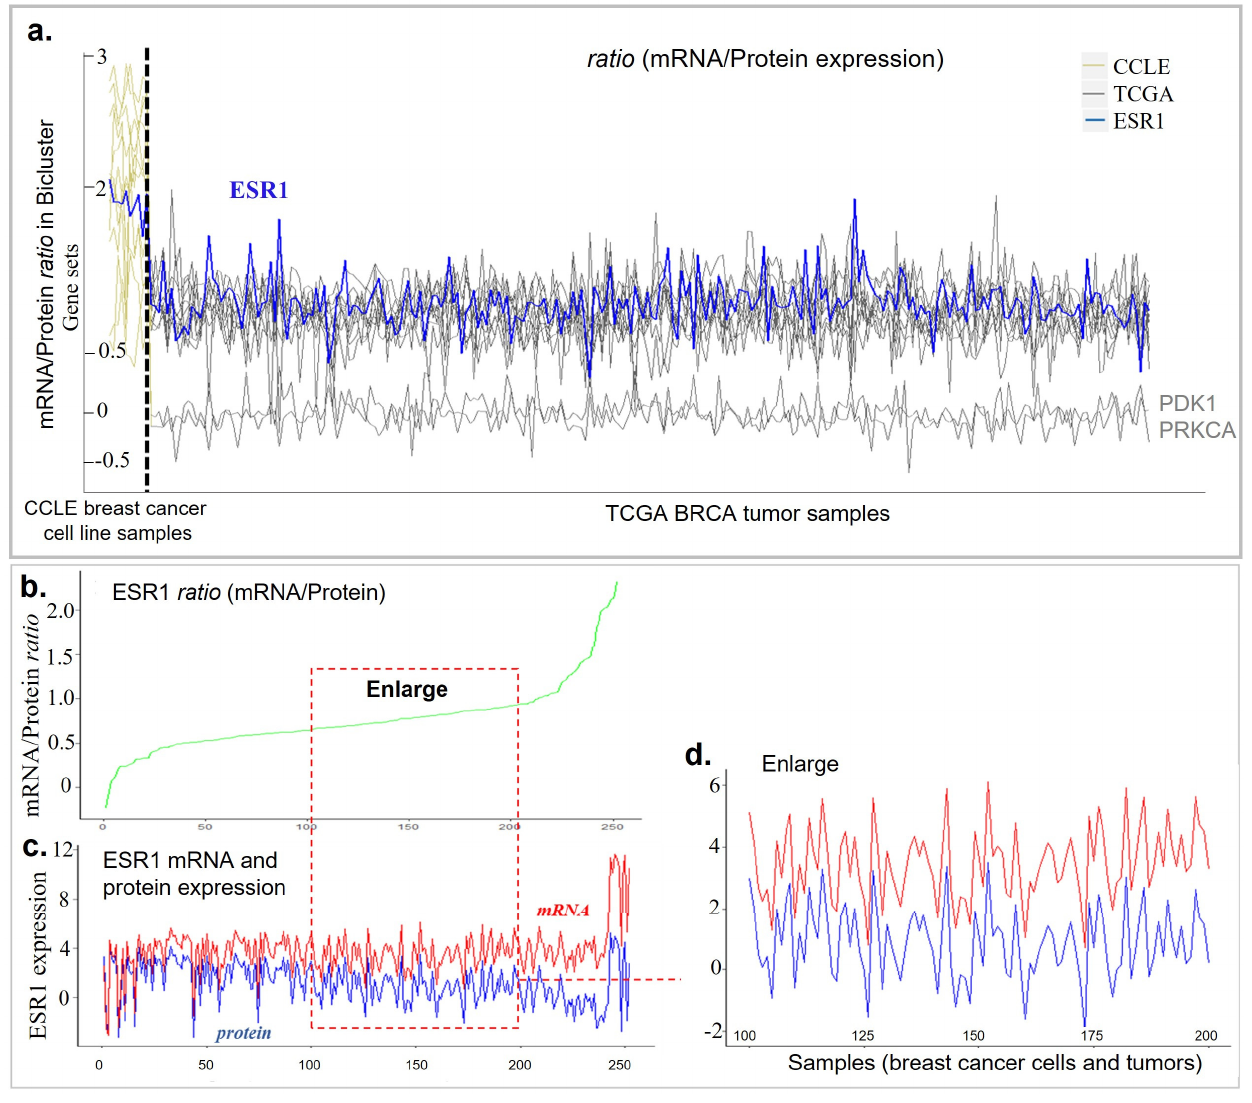
Figure 5. ( a ) Changes in the mRNA–protein ratio level of all genes across samples in the luminal A/B bicluster in breast cancer. The gray line is the ratio level of the gene in the cancer cell line (CCLE), the yellow line is the ratio level of the gene in tumor TCGA, and the blue line is the ratio level of gene ESR1. ( b ) The mRNA-protein ratio level of ESR1 across samples in the bicluster. Samples are sorted by ratio measurement. ( c ) The expression level of gene ESR1 (red) and protein ER (blue) across all samples in the luminal bicluster. Samples keep the same order as in ratio in ( b ). ( d ) The mRNA–protein ratio level of ESR1 across 100 samples in the bicluster.